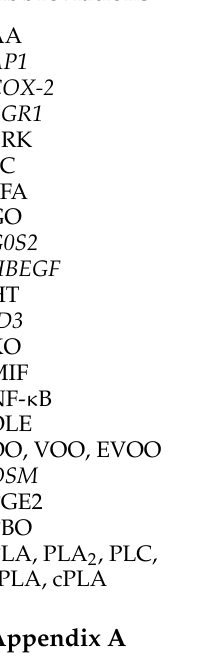
Table A1. Characteristics of study participants pre- and